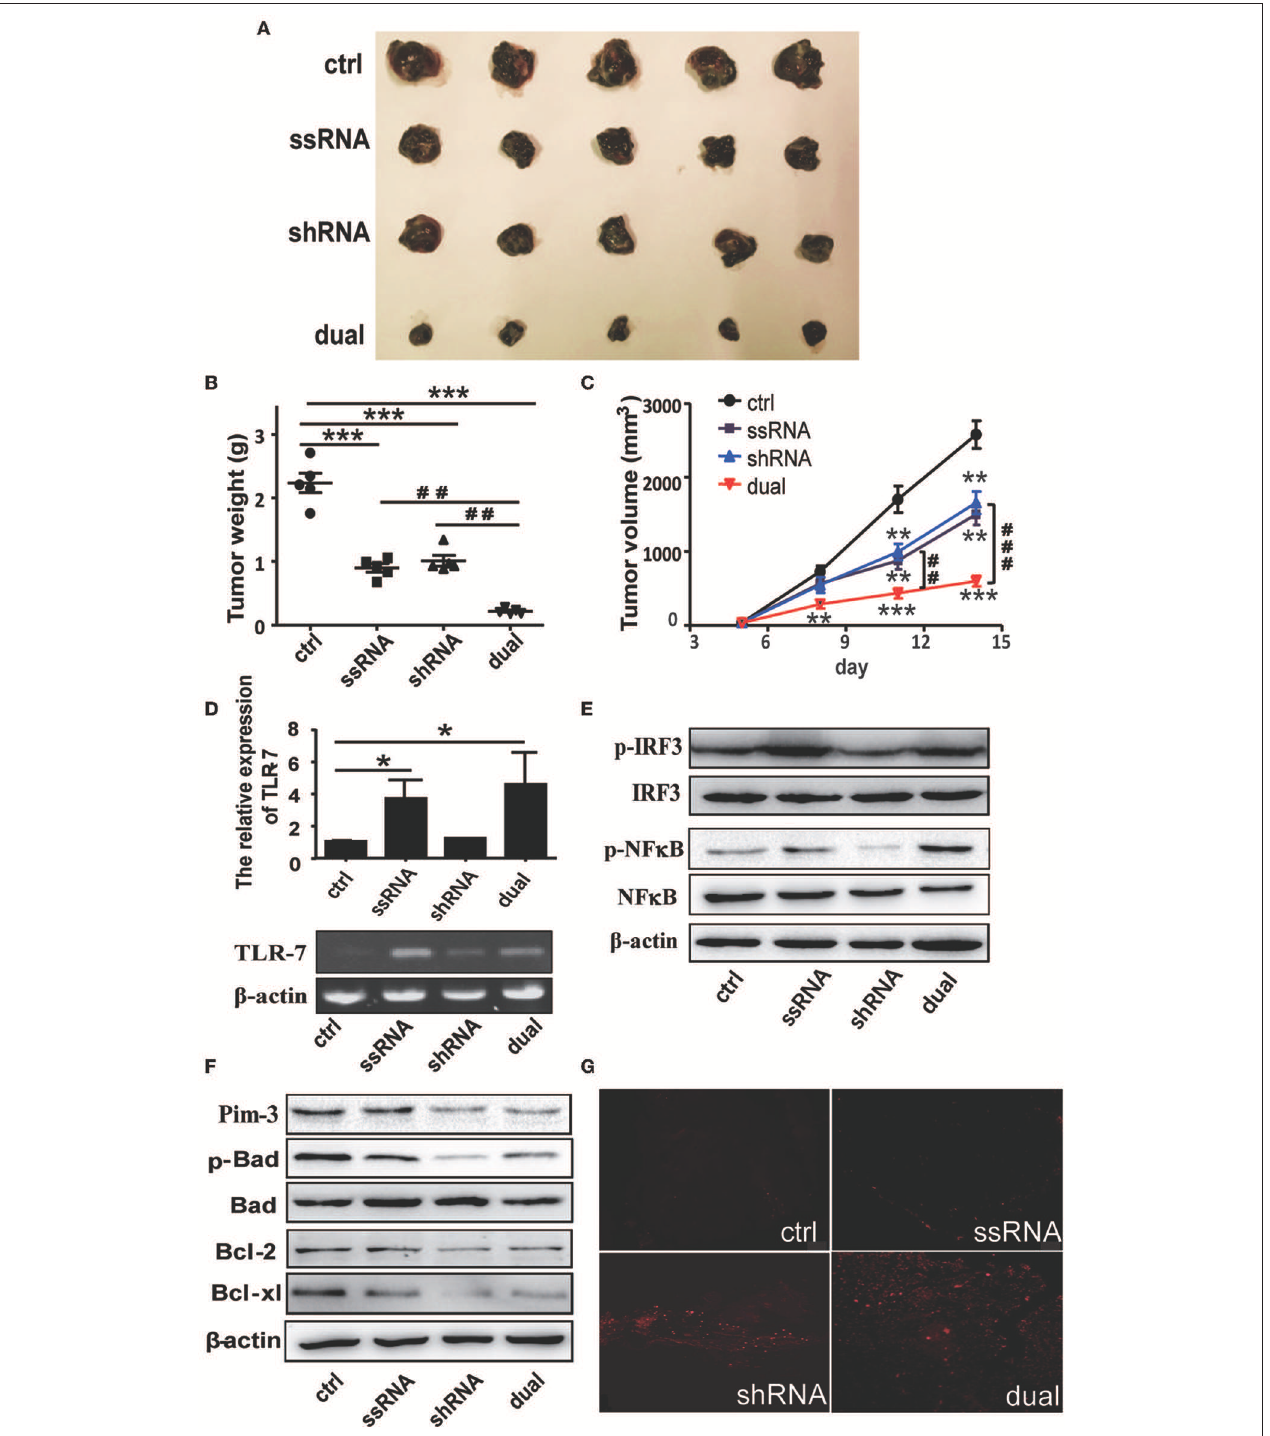
FIGURE 2 | Treatment with bifunctional vector inhibits the growth of B16F10 melanoma in vivo . (A) Tumor size after subcutaneous challenge of C57BL/6 mice with B16F10 cells and treatment with 10 µ g of the indicated vectors by intratumoral injection once every 4 days. (B) Statistical analysis of tumor weights after treatment with indicated vectors. (C) Statistical analysis of tumor volumes after treatment with indicated vectors. (D) Gene analysis of TLR7 via qRT-PCR and PCR in tumor tissue with indicated treatment. (E) Western blot detection of p-IRF3, IRF3, p-NF- κ B, and NF- κ B protein expression of tumor tissue. (F) Western blot detection of Pim-3, p-Bad, Bcl-xl, and Bcl-2 protein expression of tumor tissue. (G) TUNEL staining to evaluate apoptosis cell of tumor tissue with indicated treatment. Data are representative of three independent experiments. * P < 0.05, ** P < 0.01, and *** P < 0.001 vs. control group. ## P < 0.01 and ### P < 0.001 vs. dual group. TLR, toll-like receptor; TUNEL, terminal deoxynucleotidyl transferase-mediated dUTP nick-end labeling.